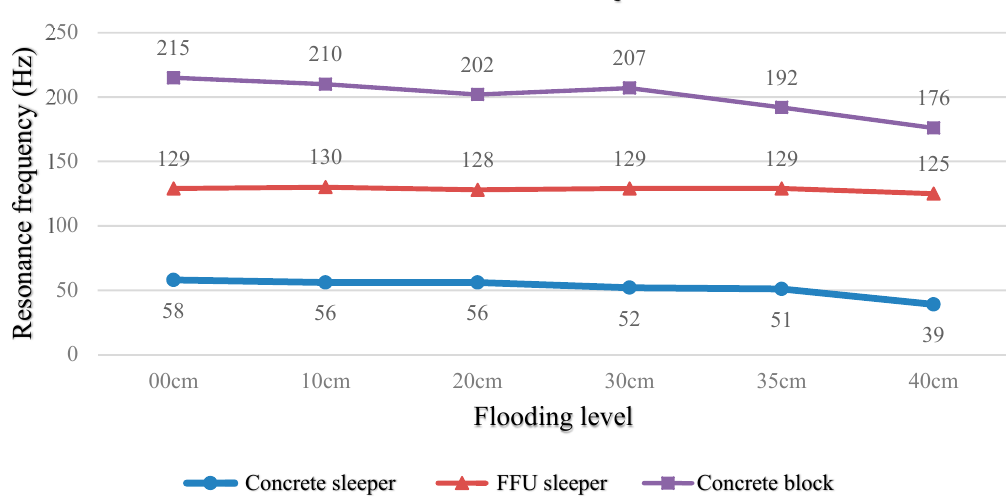
Figure 15. Resonance frequencies.